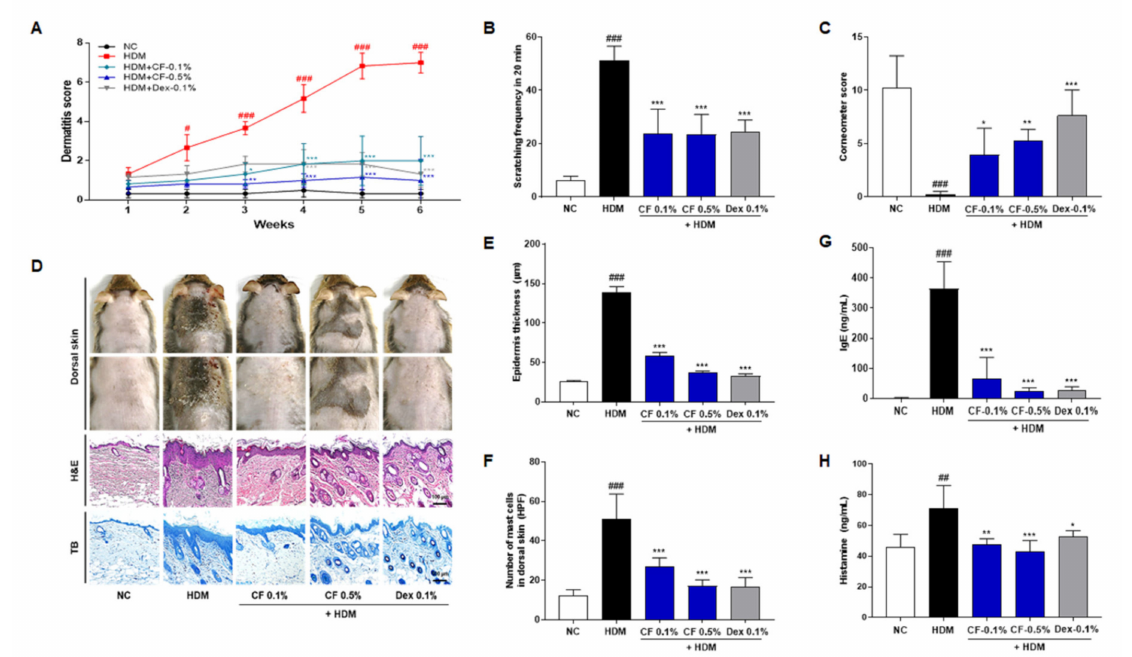
Figure 1. CF alleviates AD-like symptoms in the HDM-induced AD mouse model. ( A ) Dermatitis scores were evaluated weekly. ( B ) Scratching frequency and ( C ) skin moisture retention were evaluated on day 42 post-sensitization. ( D ) Histological features of mouse dorsal skin preparations. Tissues were excised, fixed in 10% formaldehyde, embedded in paraffin, and sectioned. Sections were stained with H&E (scale bar = 100 µ m) or with TB to identify mast cells (scale bar = 100 µ m). ( E ) Epidermal thicknesses in H&E-stained sections were measured under a microscope. ( F ) Mast cells were counted in toluidine blue-stained sections of dorsal skin tissues under a microscope. ( G ) IgE and ( H ) histamine serum levels were measured by ELISA. All data presented as means ± SEM for each group (n = 6 mice per group). Differences among groups were evaluated by one-way ANOVA, with Dunnett’s post-hoc tests; # p < 0.05, ## p < 0.01 and ### p < 0.001 compared with the NC group; * p < 0.05, ** p < 0.01, and *** p < 0.001 compared with the HDM